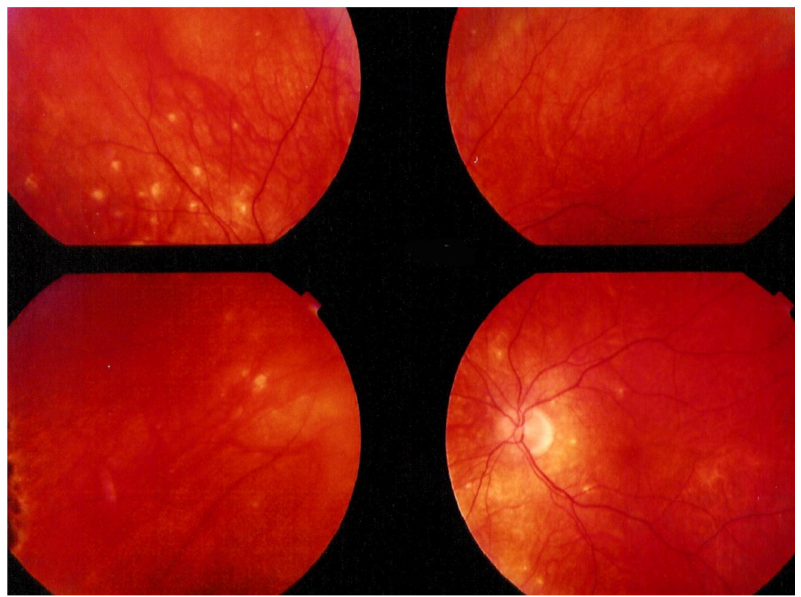
Figure 18. Fundus pictures of MFC showing retinochoroidal scars at the end of a recurrent episode followed by FA (Figure 19) ICGA (Figure 20) and by FAF (Figure 21).